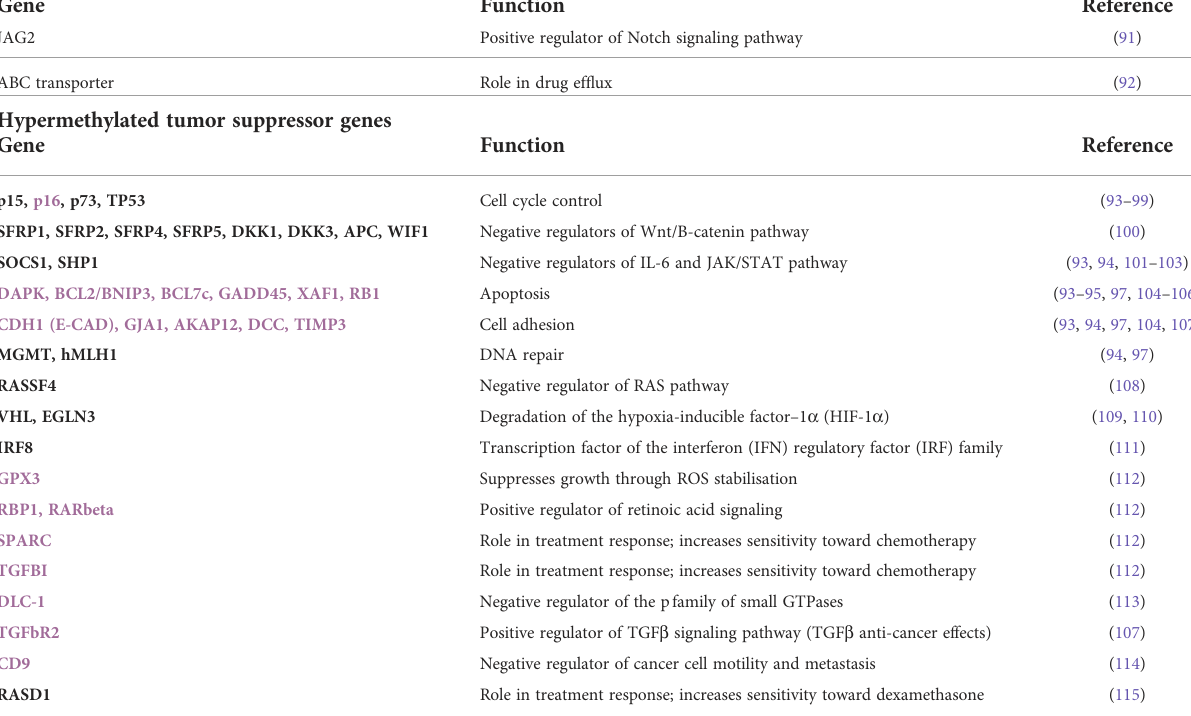
TABLE 3 List of genes that are hypo- or hypermethylated in